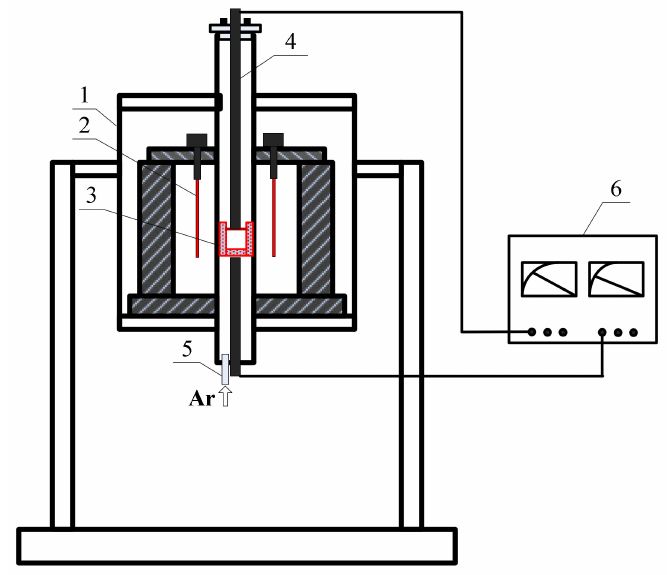
Figure 1. Electrification experimental device. Annotations: 1 furnace body, 2 MoSi 2 rod, 3 crucible, 4 energized electrode, 5 air vent, 6 pulse power supply.